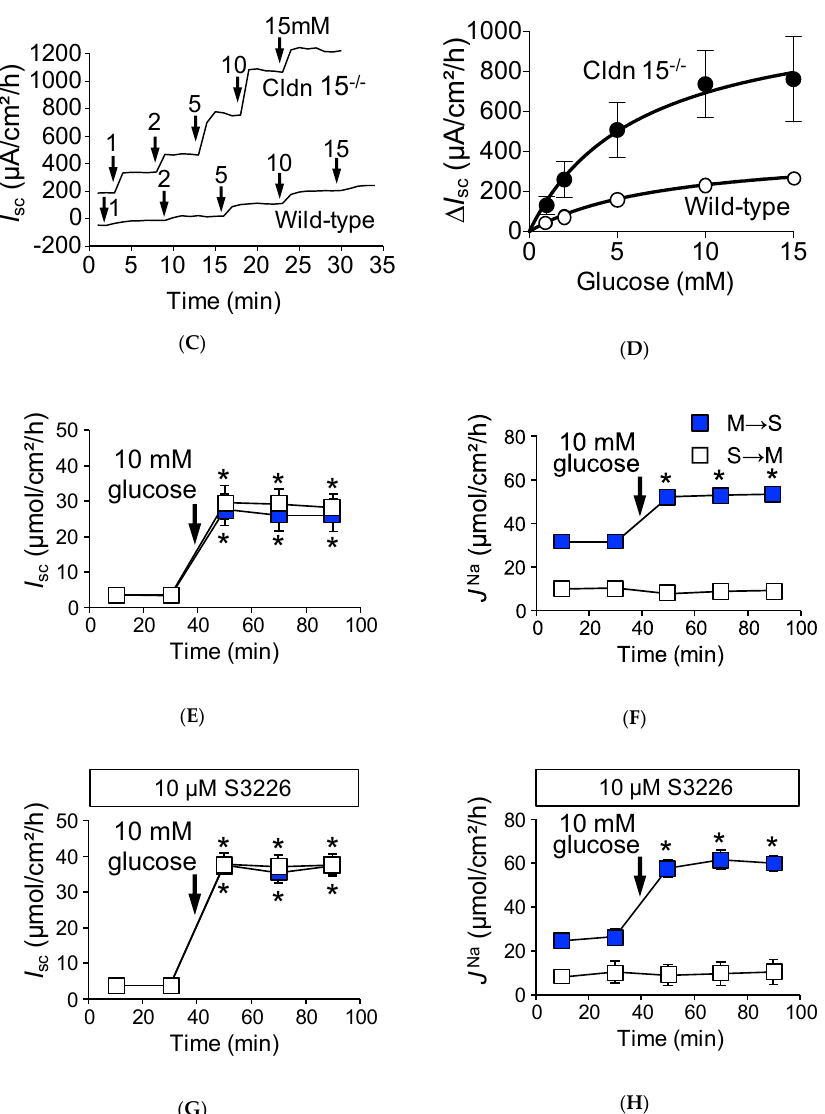
Figure 4. Representative confocal images of double immunofluorescence staining of claudin-15 (green) and occluding (red) ( A ) ( n = 3) and quantitative RT-PCR ( B ) ( n = 3) in wild-type and cldn15 − / − mice. Bar, 100 µ m. Activation of SGLT1 increases glucose-induced J Na MS under short-circuit conditions in cldn15 − / − mice: Representative I sc trace of glucose-induced I sc changes in cldn15 − / − and wild-type mice ( C ), where, indicated by the arrows, glucose was added to the mucosal side, the final concentration of glucose is shown in mM; and the concentration dependence of the glucose-induced I sc ( D ). The curve was fit to the Michaelis–Menten equation ( n = 3 and 6, wild-type, and cldn15 − / − mice, respectively). Where error bars are absent, they are smaller than the symbol used. The 10 mM glucose-induced short-circuit current changes ( I sc ) ( E ) and 22 Na + unidirectional flux changes ( J Na ) ( F ) were measured simultaneously the same as Figure 1 ( n = 7 and 7, M to S and S to M, respectively). Where indicated by the arrows, glucose was added to the mucosal side. The e ff ect of S3226 on glucose-induced ∆ I sc ( G ) and ∆ J Na ( H ) ( n = 5 and 5, M to S and S to M, respectively). Where indicated by the arrows, glucose was added to the mucosal side. Each point represents the mean ± SE. Where error bars are absent, they are smaller than the symbol used. * p < 0.05 as compared with the baseline